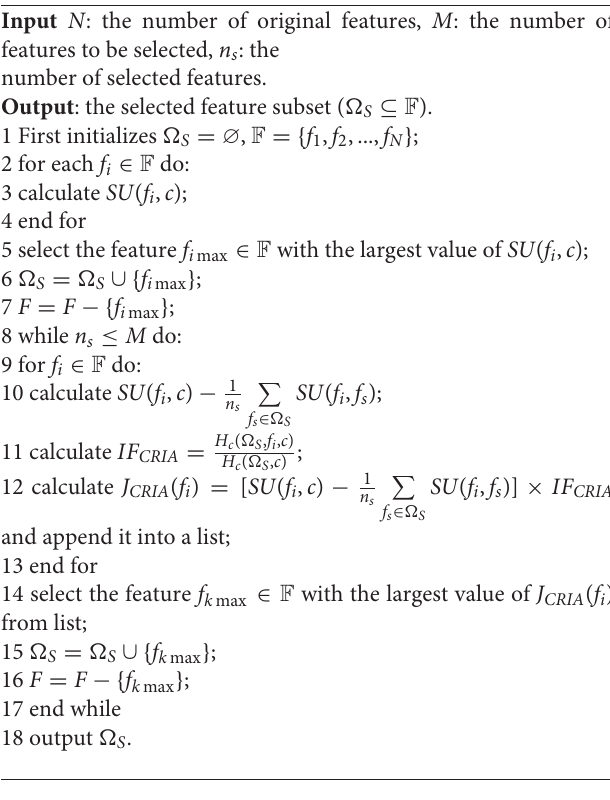
Algorithm 1 | CRIA: correlation-redundancy and interaction analysis based gene selection